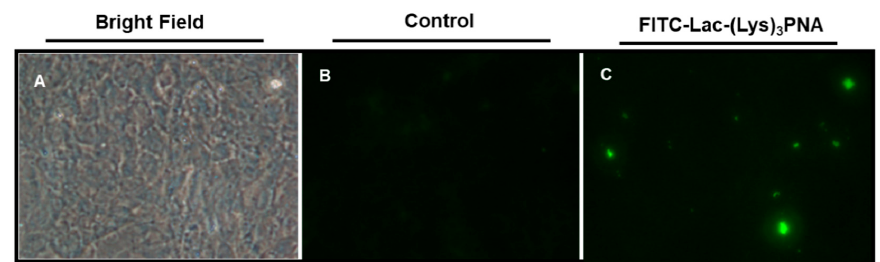
Figure 1. Uptake of FITC-Lac-PNA in HepaRG cells. HepaRG cells were plated and incubated at 37 °C, 5% of CO 2 with FITC-Lac-(Lys) 3 -PNA conjugates for 24 h. At the end of treatment, cells were observed by fluorescence microscopy ( A ) Bright field; ( B ) Control cells; ( C ) FITC-Lac-(Lys)3-PNA. FITC = fluorescein isothiocyante; Lac = lactose; PNA = peptide nucleic acids; Lys = lysine.